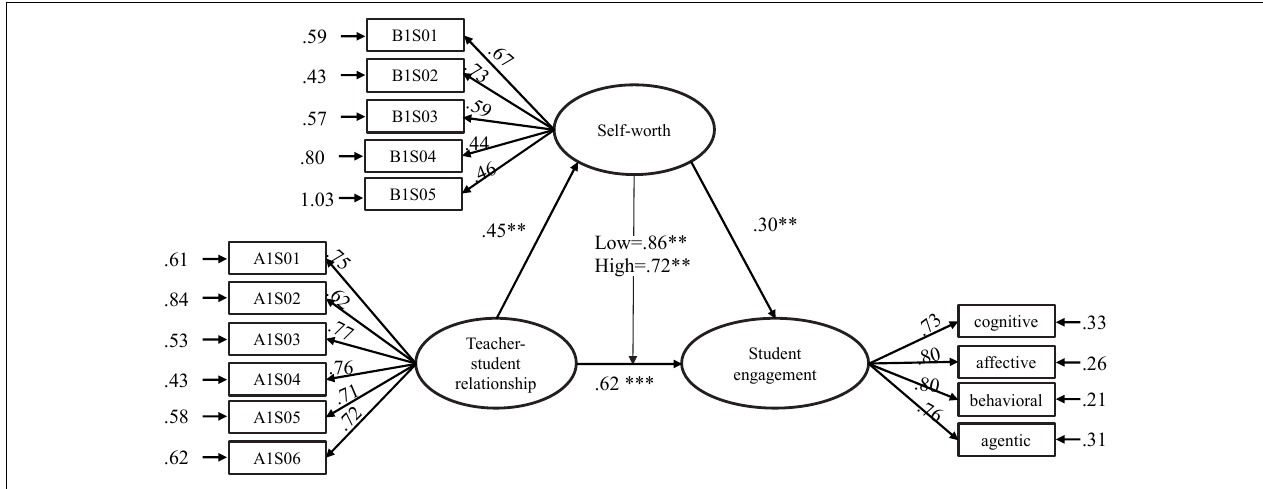
FIGURE 3 | Structural equation modeling (SEM) with path coefficients. ** p < 0.01; *** p <